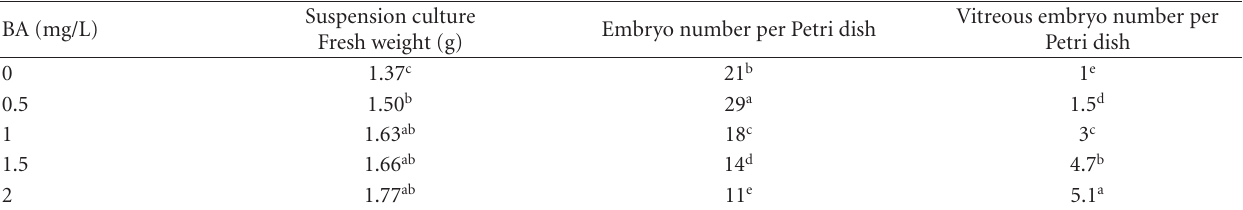
Table 1: Influence of BAP on the biomass changes in suspension cultures and somatic embryos development after 5 weeks on PGR-free medium.